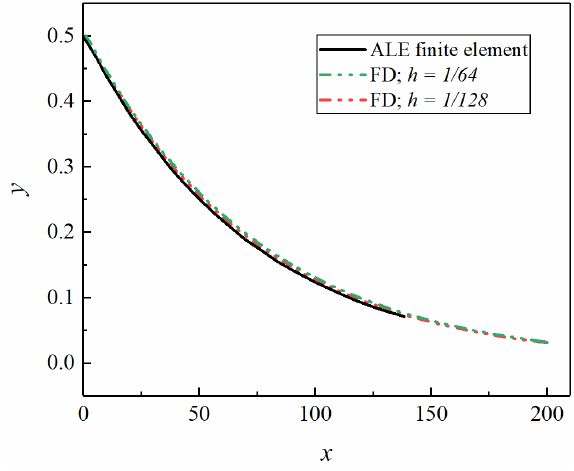
Figure 1. Comparison of the lateral trajectory of a particle in a Poiseuille flow of Oldroyd-B fluid. ( Wi = 0.5, Re = 0.5, η r = 0.5, d/H = 0.15).